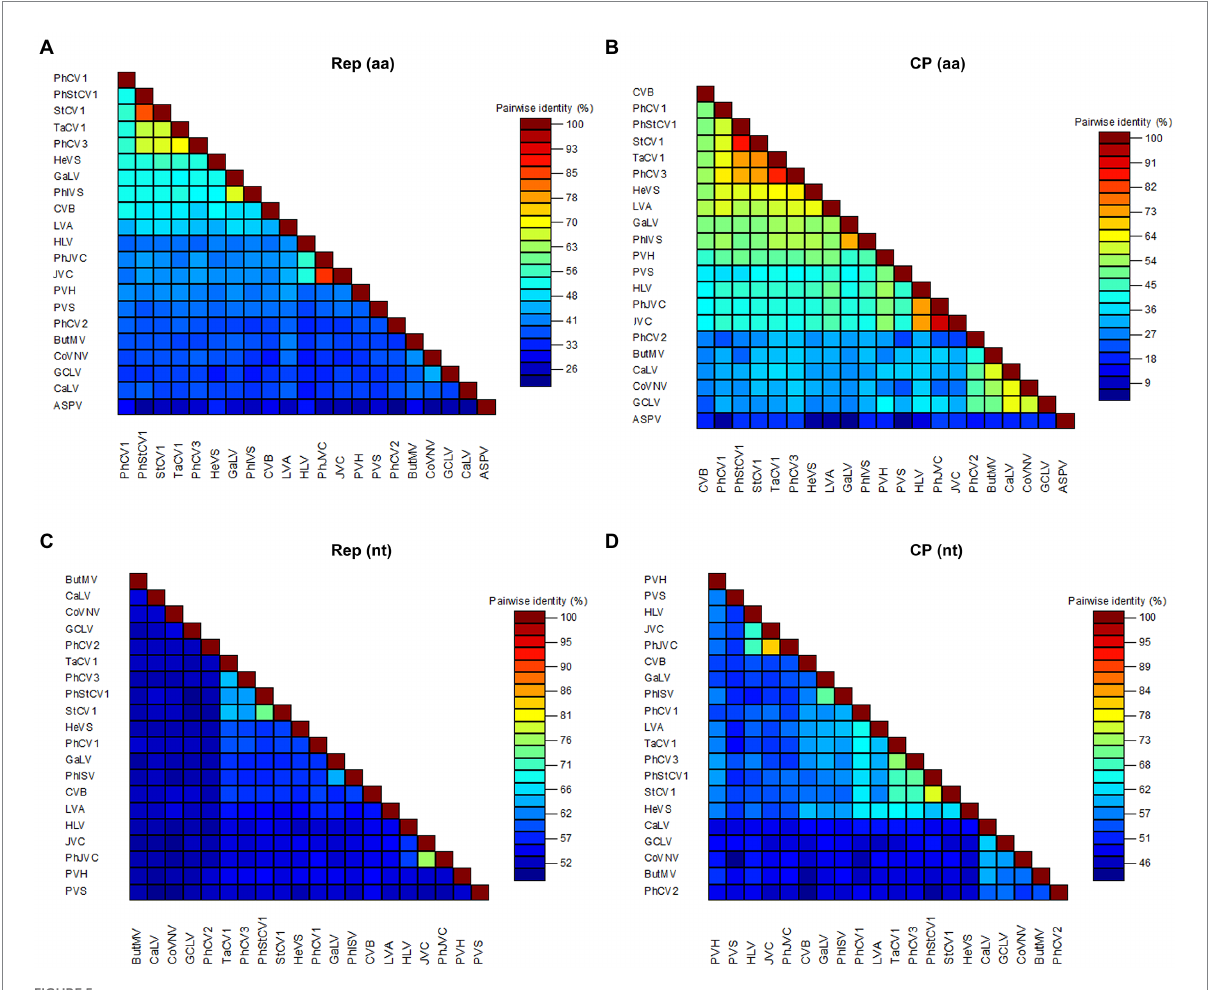
FIGURE 5 The pairwise identities plot of Reps and CPs in the genus of Carlavirus based on amino acid (aa) sequence (A) (B) and nucleotide (nt) sequence (C) (D) aligned by MAFFT and displayed by SDT software. Rep, viral replicase; CP, coat